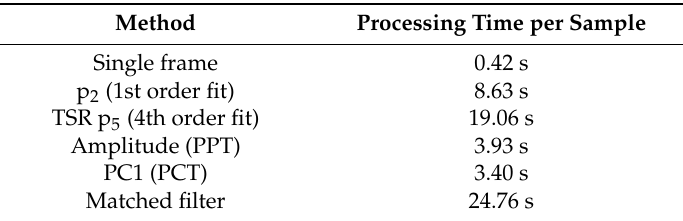
Table 2. Processing times for each of the six thermal output images on a 3.40-GHz processor. PPT, pulsed phase thermography; PCT, principal component thermography.